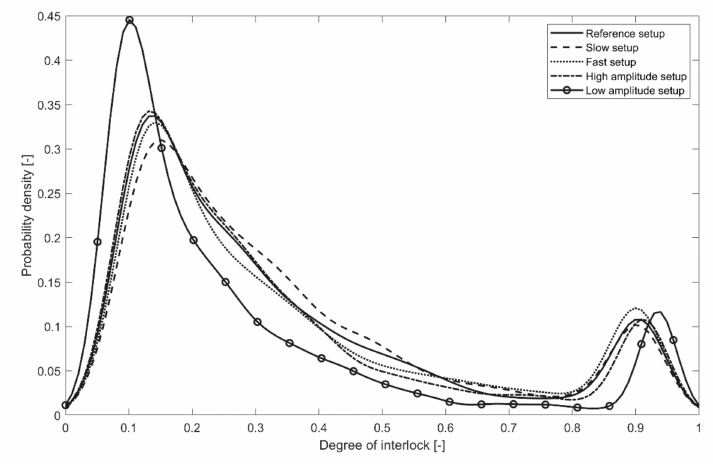
Figure 13. Degree of interlock distribution among nodes for the performed setups.